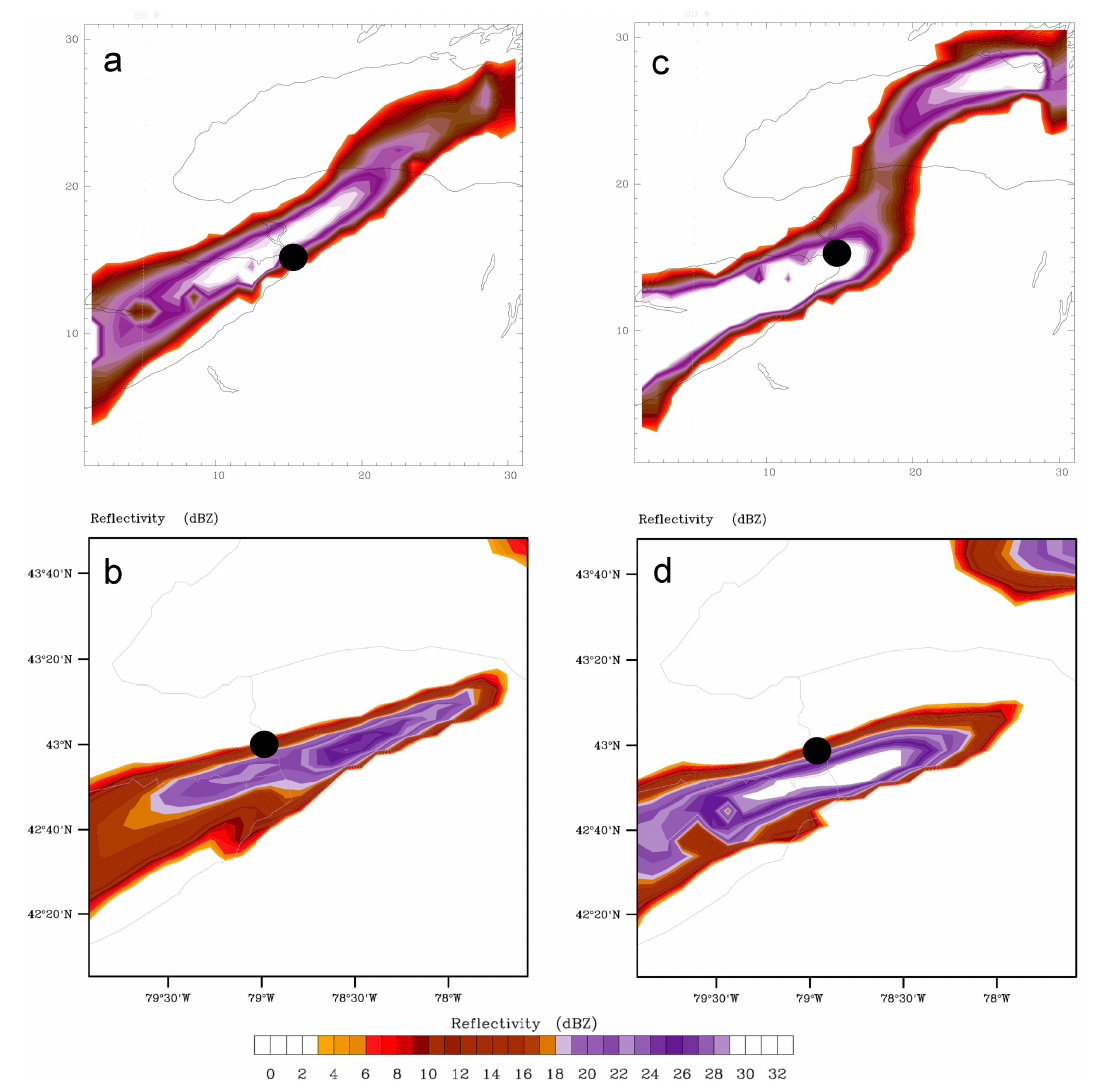
Figure 7. Radar images (domain 2, 9km resolution) simulated by MM5 ( a and c ) and WRF ( b and d ) on 24 December 2001, 12:00UTC with a Lake Erie temperature + 4K (a and b) and + 10K (c and